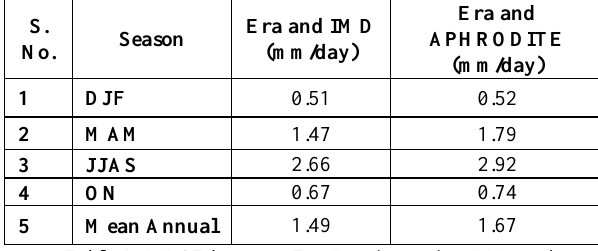
Table 3. RMSE between Era-Interim against IMD and APHRODITE rainfall products for all the seasons